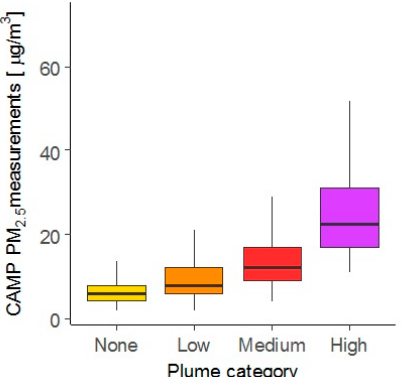
Figure 4. Boxplots (without outliers) showing plume categories and the corresponding PM 2.5 concentration